Question: What form of chart is displayed?
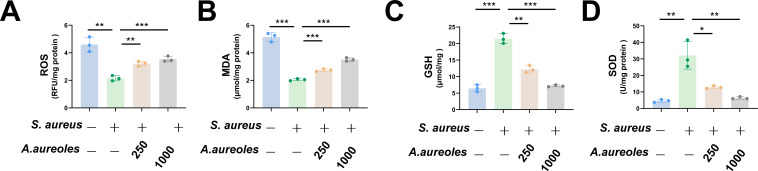
Answer: bar